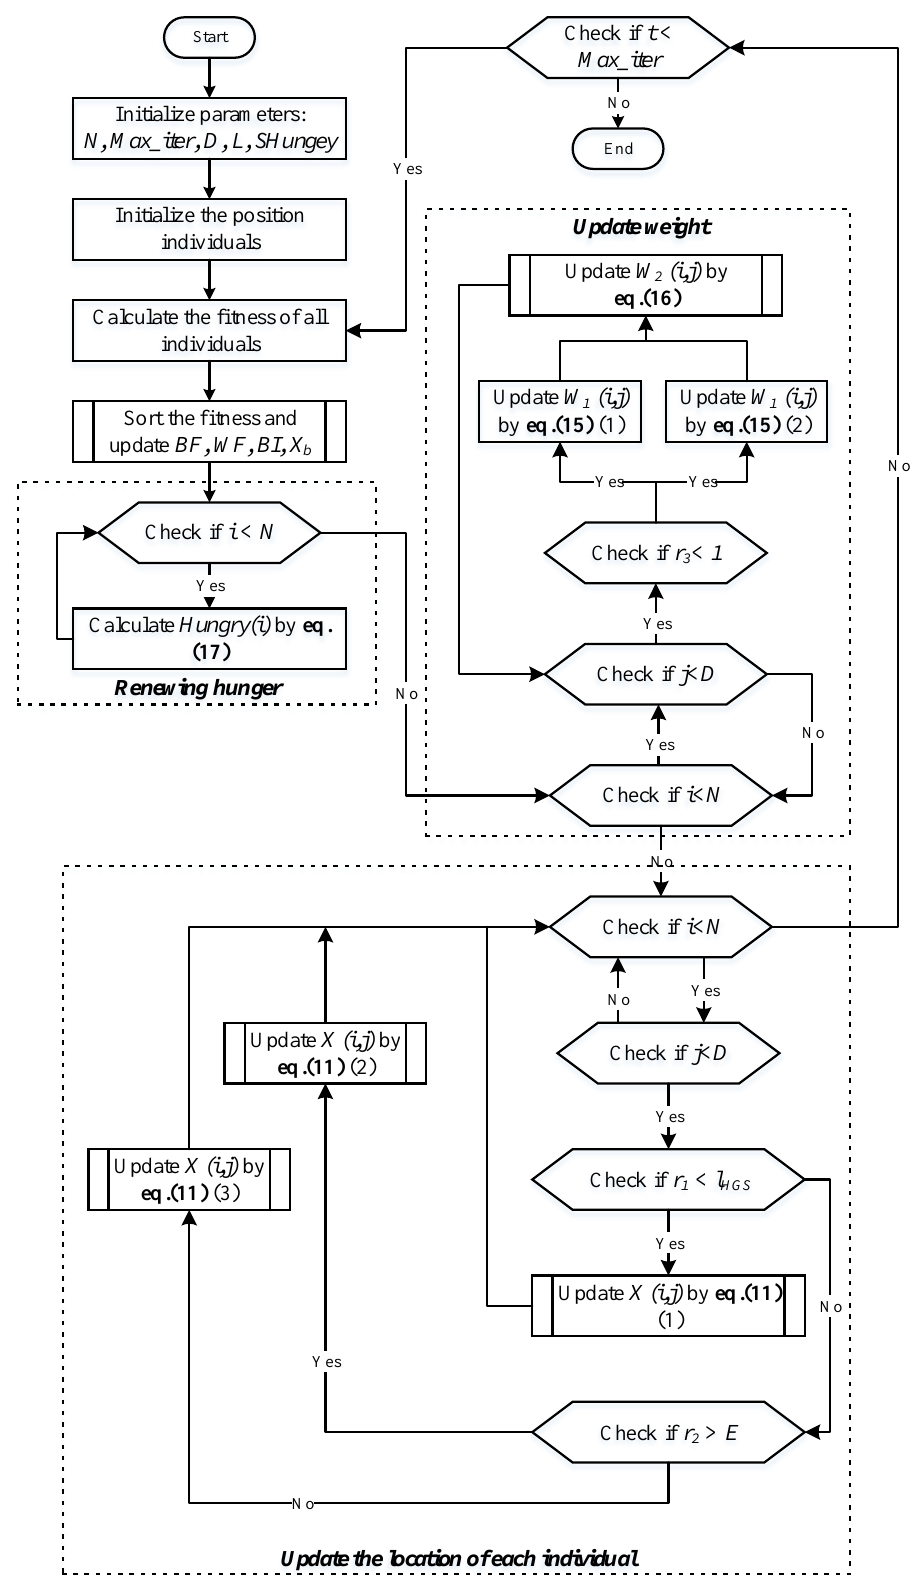
Figure 1. Flowchart of the HGS algorithm.